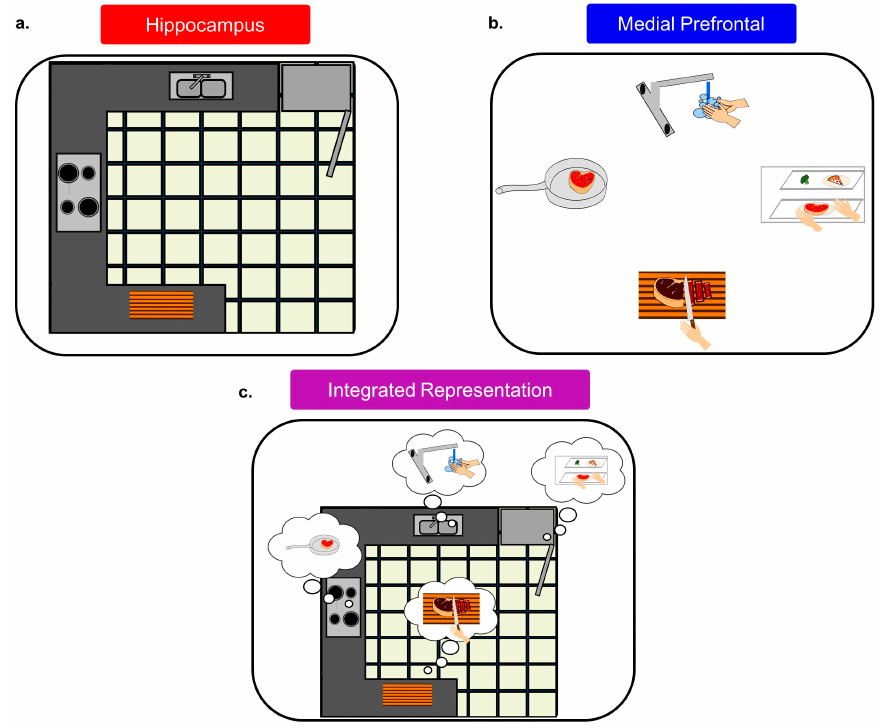
Figure 4. Schematic of the unique coding properties of the hippocampus (HC) and medial prefrontal cortex (mPFC), and their integration. ( a ) purely spatial coding in HC; ( b ) behaviorally-driven coding in mPFC; ( c ) in the integrated representation, the appropriate behaviors are associated with locations.